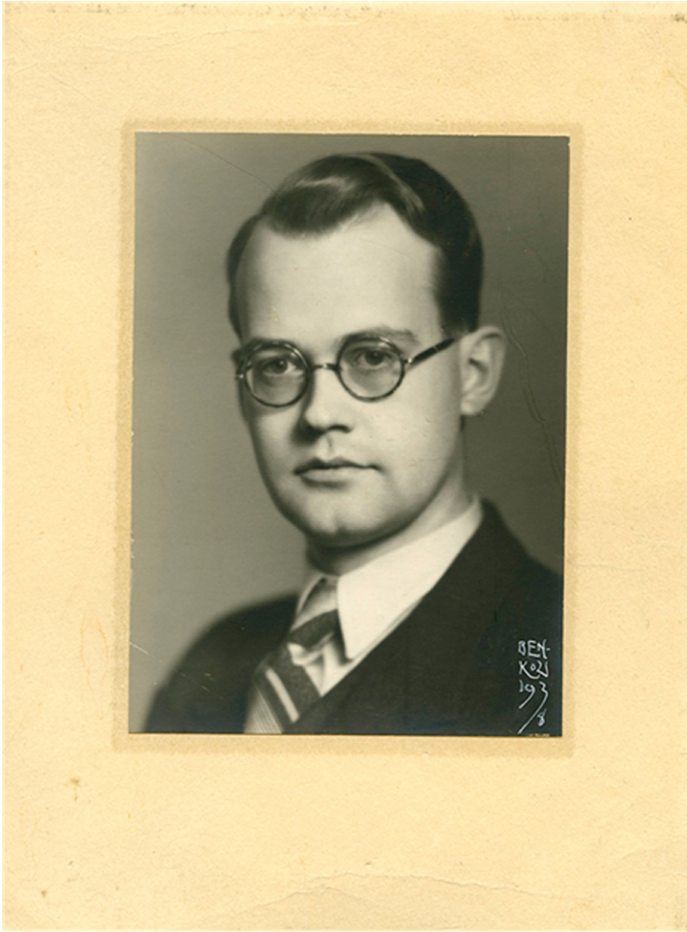
Figure 1. Gunnar Jungner, at 24 years of age. Photograph taken at the engagement to Greta Nelson in